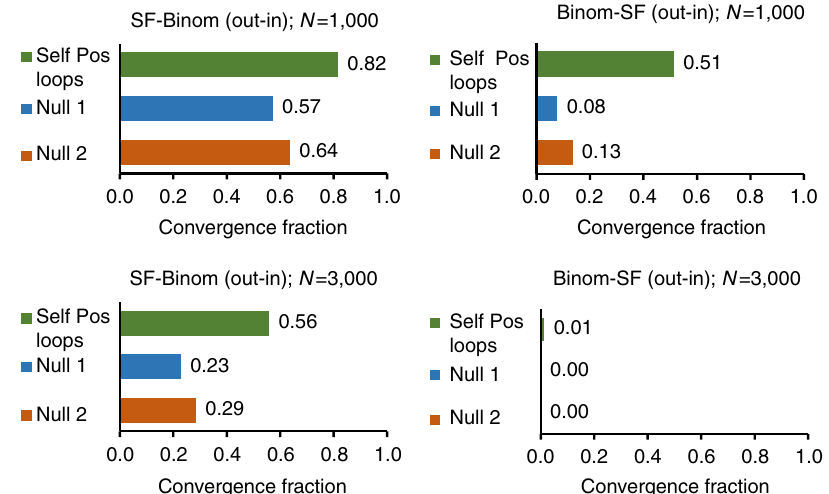
Figure 4 | Effect of positive autoregulation on convergence fractions. Positive autoregulatory loops were added randomly to 10% of the nodes in four ensembles, each comprising 500 networks of a given size ( N ¼ 1,000 or 3,000) and topology (SF-Binom or vice versa). Convergence in each ensemble is compared to controls without extra loops, with and without matching of the degree distributions to the enriched ensemble (Null 1 and Null2, respectively). Parameters of the SF and Binom distributions (prior to addition of loops) are: SF, ( a ¼ 1, g ¼ 2.4) and Binomial, ( p ¼ 3 : 5 a ¼ 100, e ¼ 3, c ¼ 0.2, D ¼ 10 (cid:2) 3 and y (cid:5) ¼ 0.